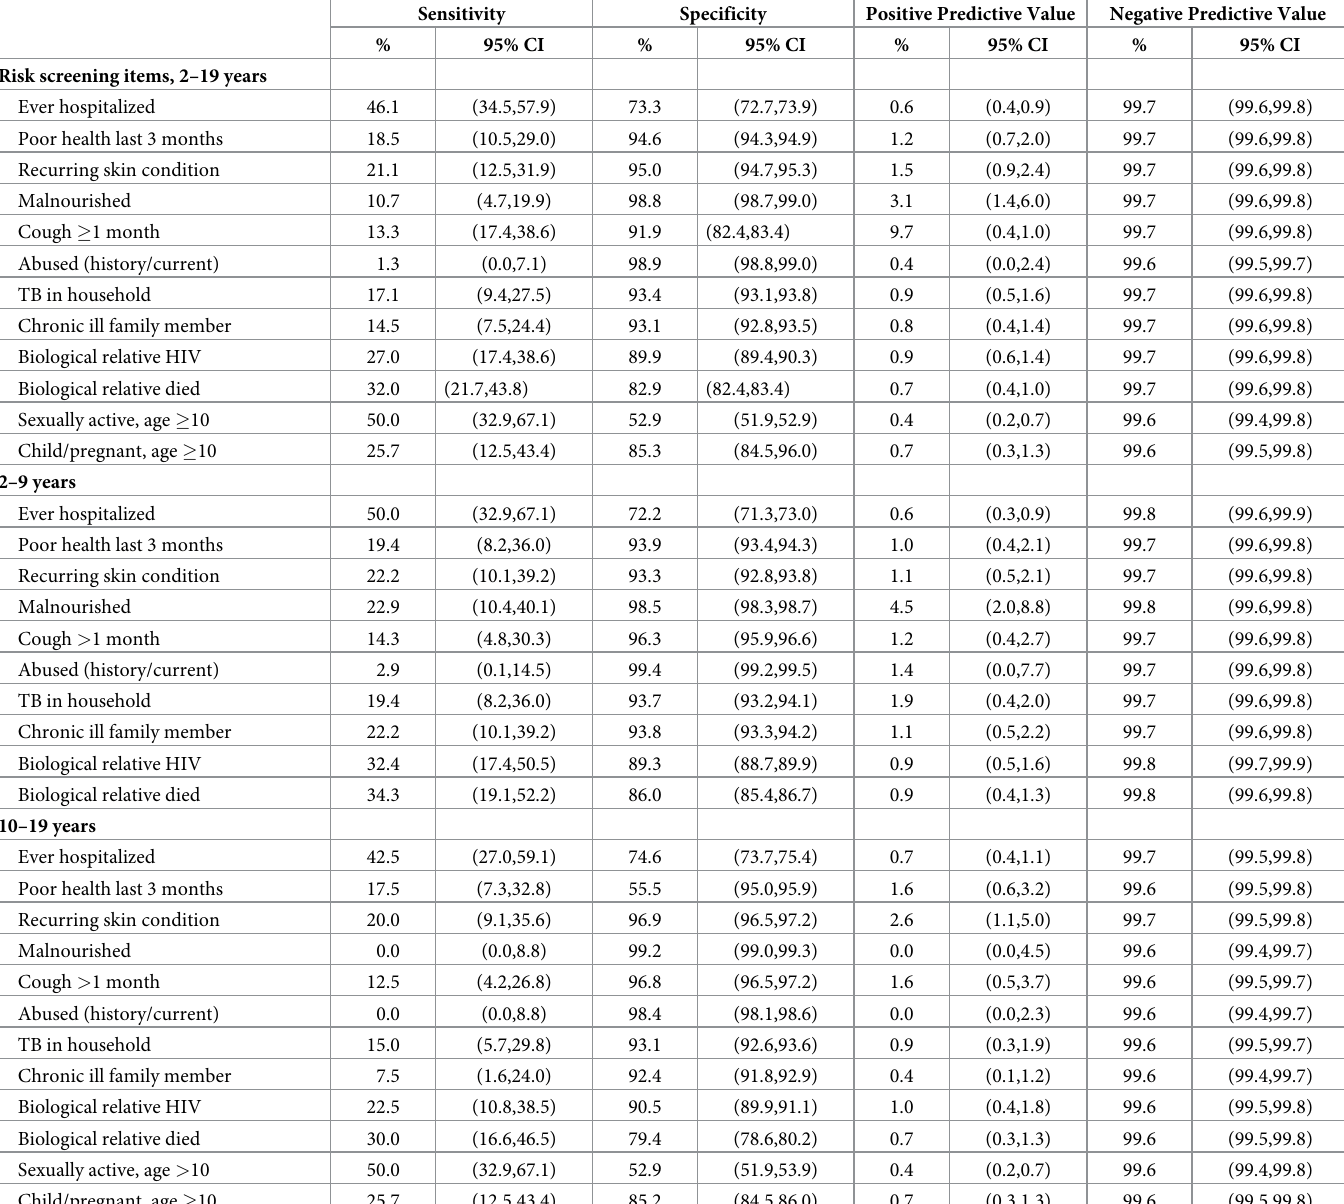
Table 2. Sensitivity, specificity, PPV and NPV of individual risk screening items, all among children and adolescents 2–19 years (N = 21,008), and by age group ( < 10, �